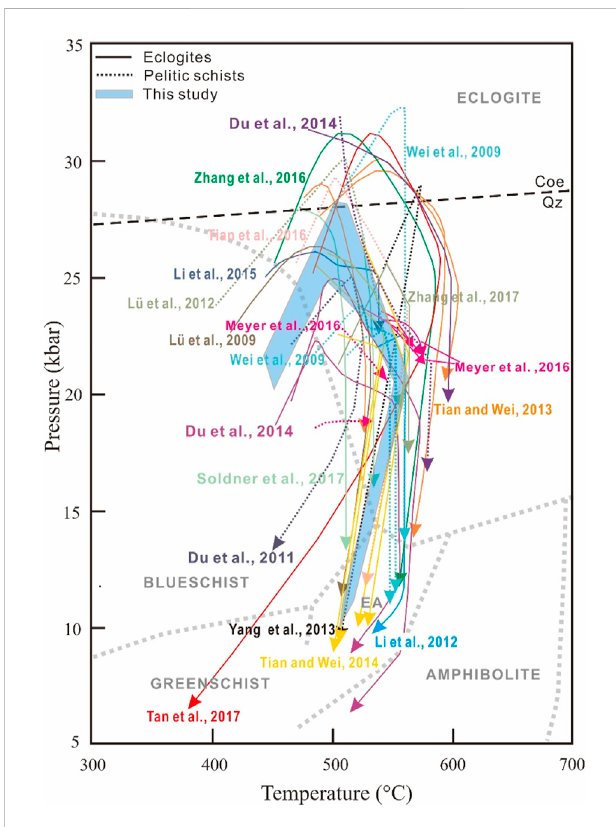
Compilation of P-T paths of eclogites and mica schists from the Western Tianshan HP-UHP metamorphic belt calculated by pseudosection modeling. The studies corresponding to the P-T paths are included in the list of